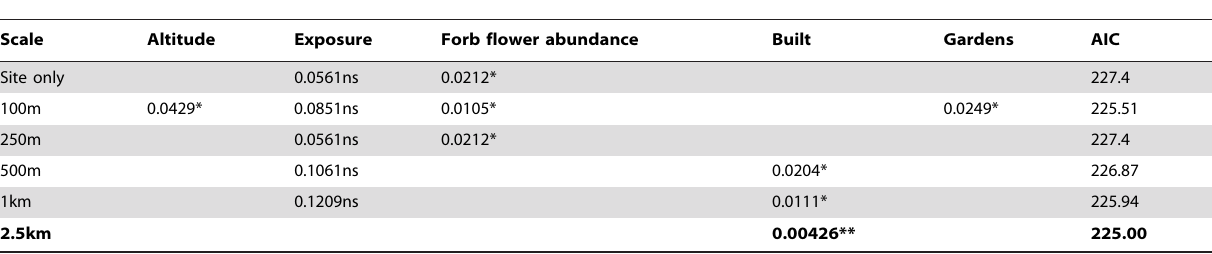
Table 2. Generalized linear models for total bee abundance.